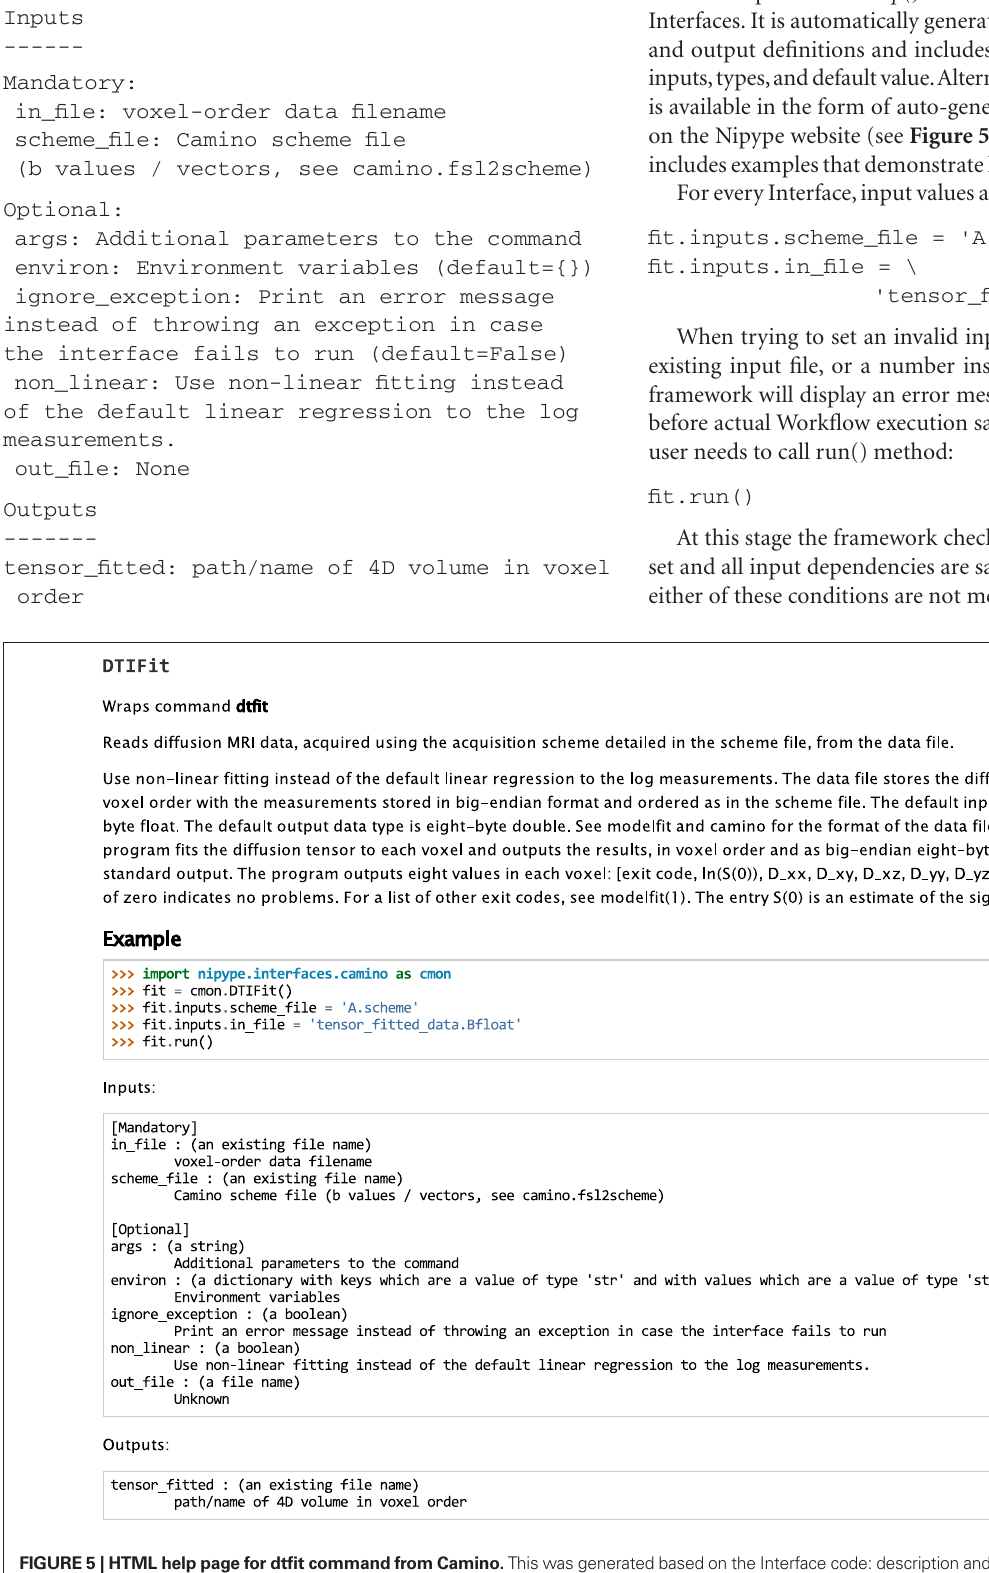
FiGure 5 | HTML help page for dtfit command from Camino. This was generated based on the Interface code: description and example was taken from the class docstring and inputs/outputs were list was created using traited